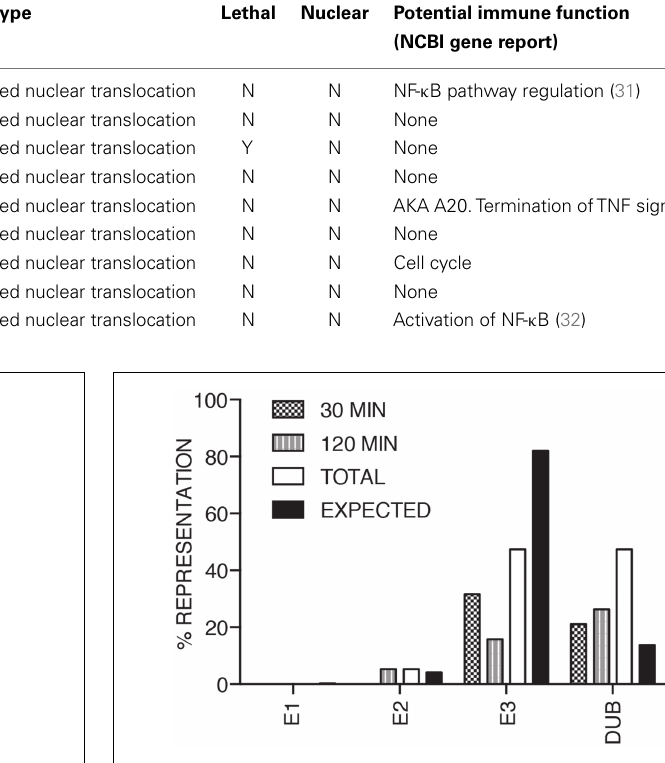
FIGURE 4 |The bar chart shows the relative percentages of E1, E2, and E3 ubiquitin ligases, and deubiquitylation enzymes identified as modifiers of theTNF pathway at 30, 120minTNF exposure and in total . The expected column shows the anticipated distribution assuming a normal representation of the respective functional